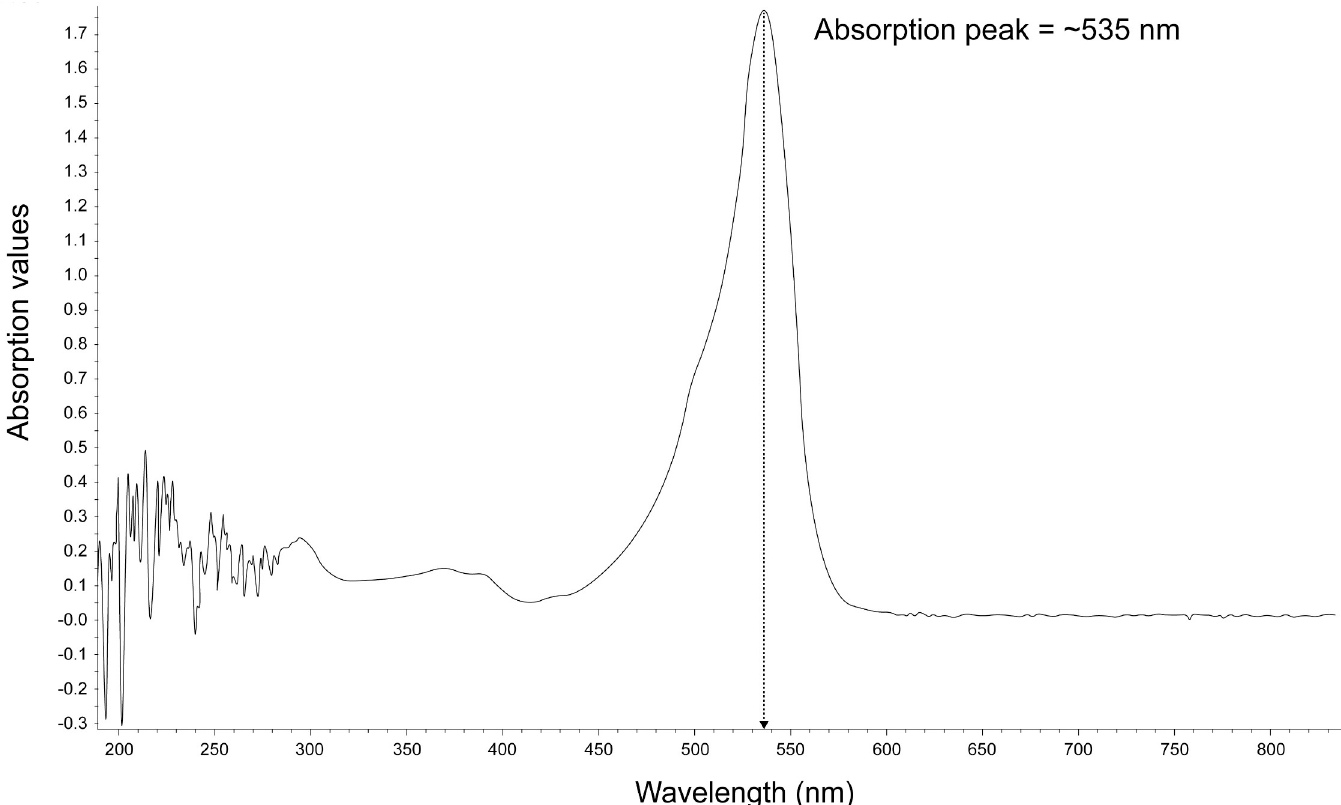
Fig 2. Absorbance profile (200–700 nm) of the crude extracted prodigiosin. Red prodigiosin in the extracted sample is detectable at a maximum of 535 nm.